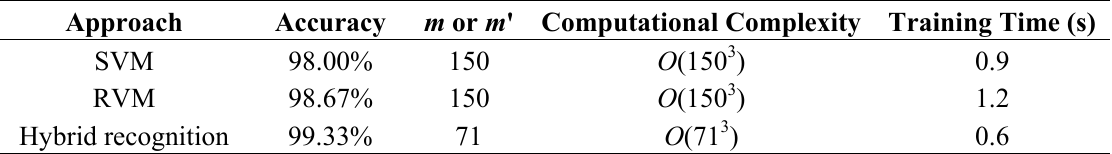
Table 6. In the first part of experiment 2, the recognition accuracy of Iris data set and computational complexity are compared among three approaches.